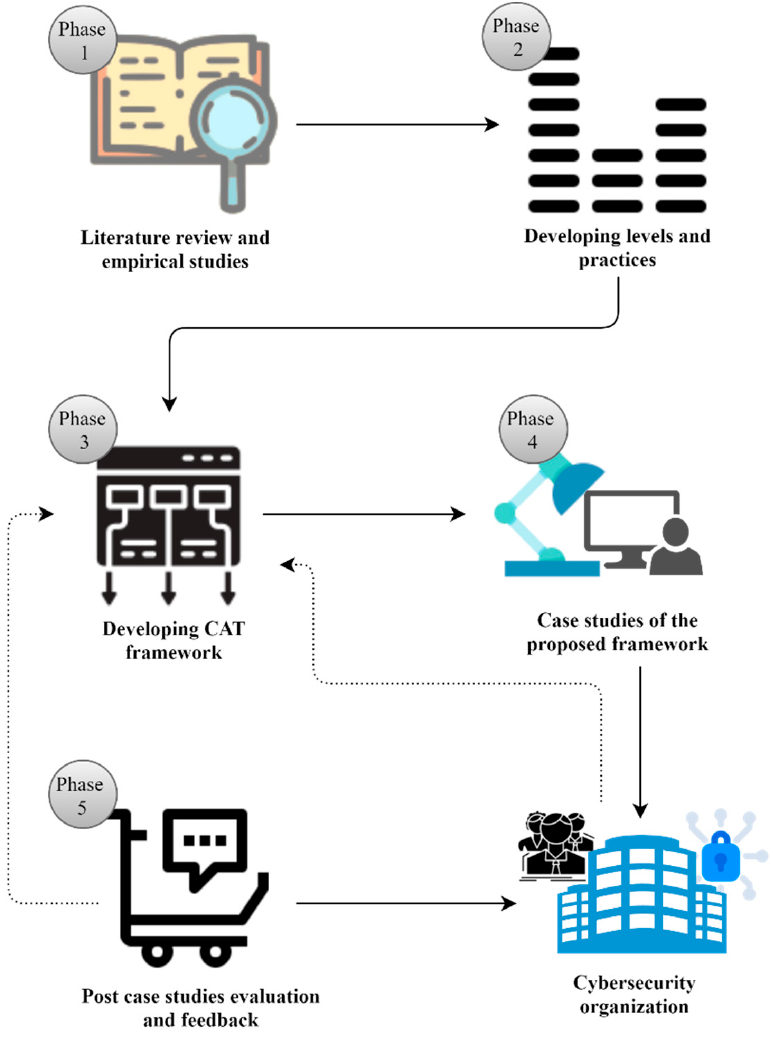
Figure 1. Proposed research methodology .